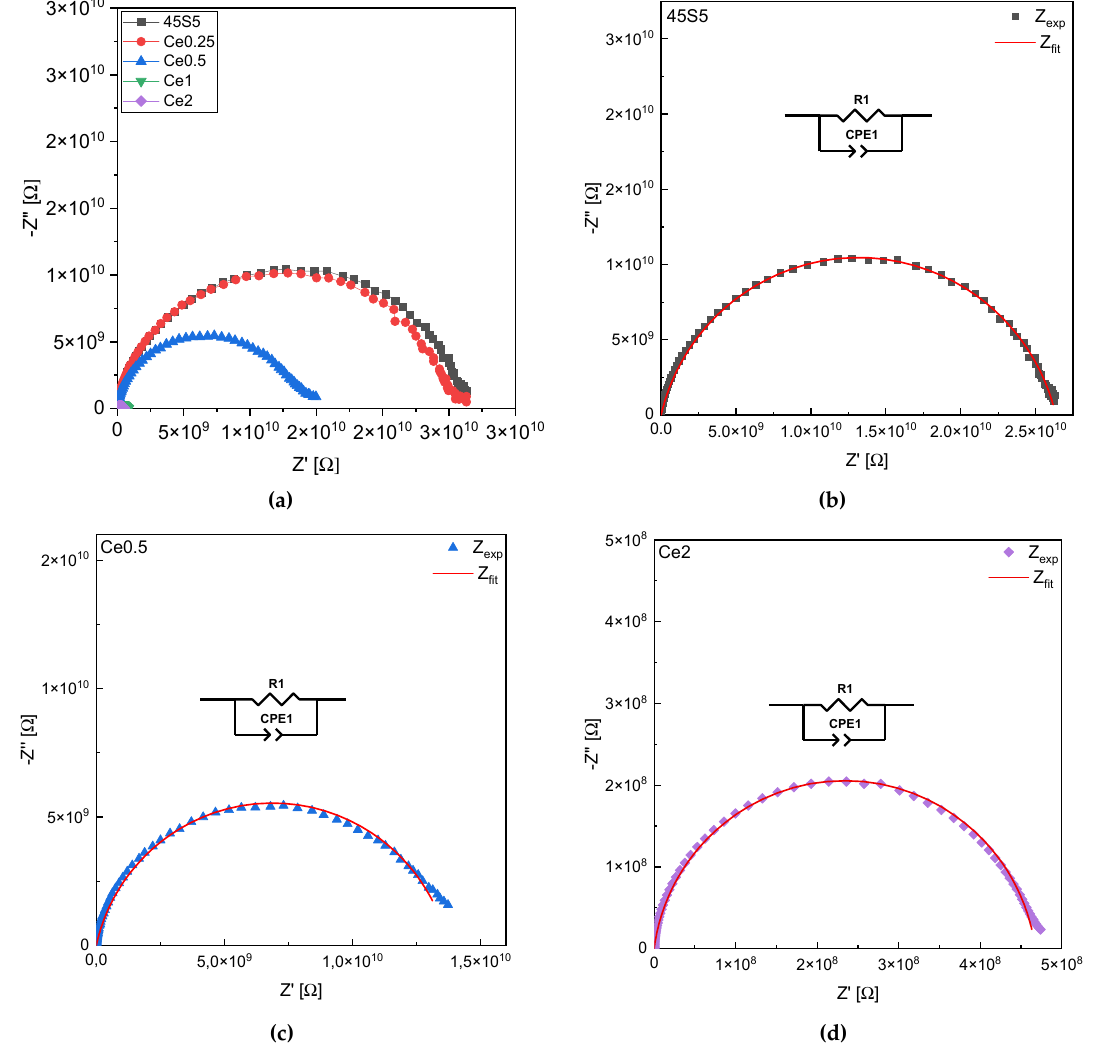
Figure 7. Z (cid:4593) versus Z (cid:4593)(cid:4593) for all samples, at 37 °C. Figure 7. Z (cid:48) versus Z (cid:48)(cid:48) , measured at 37 ◦ C for ( a ) all samples ( b ) 45S5 sample ( c ) Ce0.5 sample and ( d ) Ce2